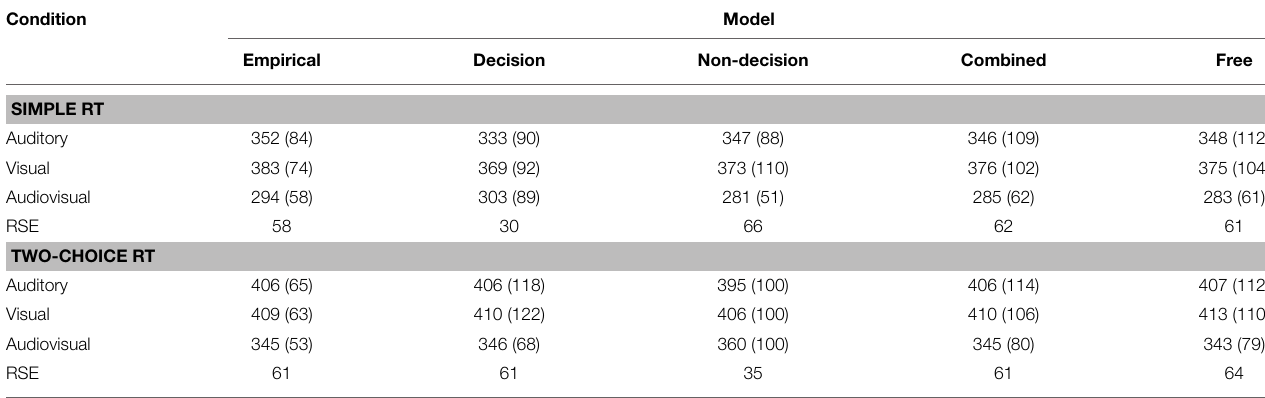
TABLE 3 | Mean response times (and standard deviations in parentheses) of the empirical and model data for Experiment 1 (simple RT) and Experiment 2 (two-choice RT). Condition Model Empirical Decision Non-decision Combined Free